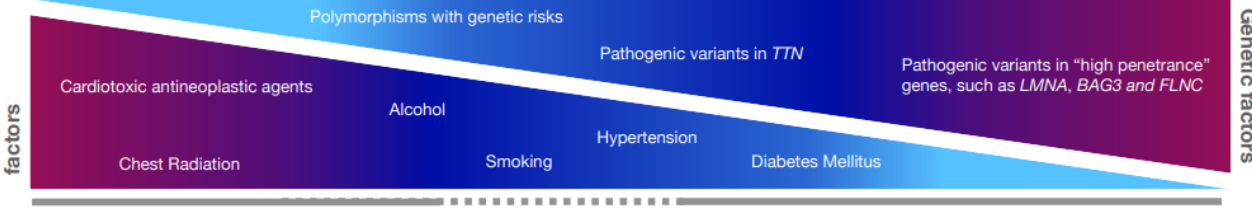
Figure 2. Schematic overview of genetic susceptibility and environmental factors affecting dilated cardiomyopathy. This schematic overview illustrates on the right a more mendelian risk profile with pathogenic variants in “high penetrance” genes versus a more multifactorial risk profile on the left. Importantly, the truth may be a combination of both, e.g., Titin ( TTN ) variants in patients with dilated cardiomyopathy with alcohol abusus. Polygenic risks may also affect disease in pathogenic variants in “high penetrance” genes.